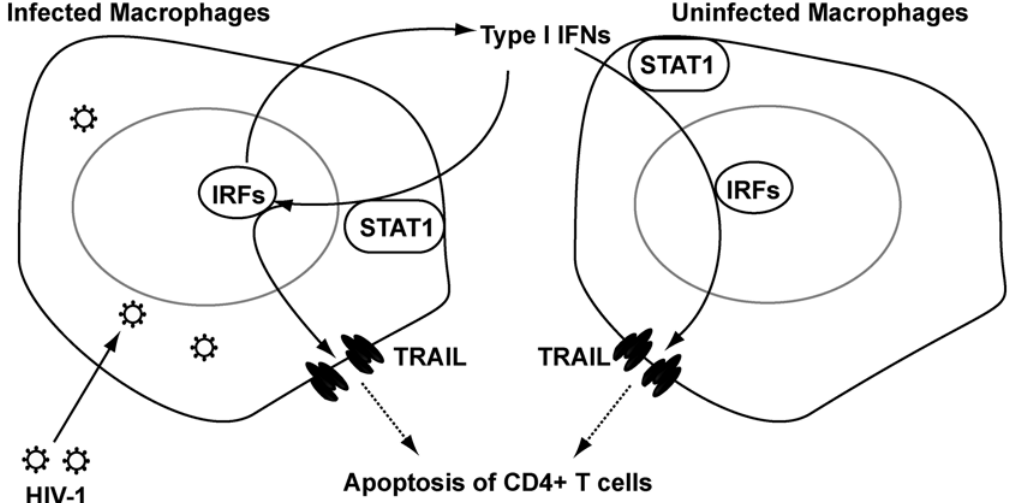
Figure 8. A feedback loop among Type I IFNs and IRFs regulates TRAIL Expression in HIV-1-infected macrophages. A positive feedback loop exists among intracellular IRFs gene expression and soluble type I IFNs induction in macrophages during HIV-1 infection. HIV-1 infection induces IRF-1 and IRF-7 gene expression. IRF-1 and IRF-7 promotes type I IFNs activities and activate STAT1. Type I IFNs diffuse and further promote STAT1 activation and IRF-1 and IRF-7 expression in uninfected macrophages. Blocking of either IRF-1, IRF-7, type I IFNs, or STAT1 reduces TRAIL expression. TRAIL has been reported to mediate the apoptosis of CD4 + T cells and participate in HIV-1 pathogenesis. ## indicates p , 0.01 when compared to HIV group with siRNA control. Data are representative of three donors.